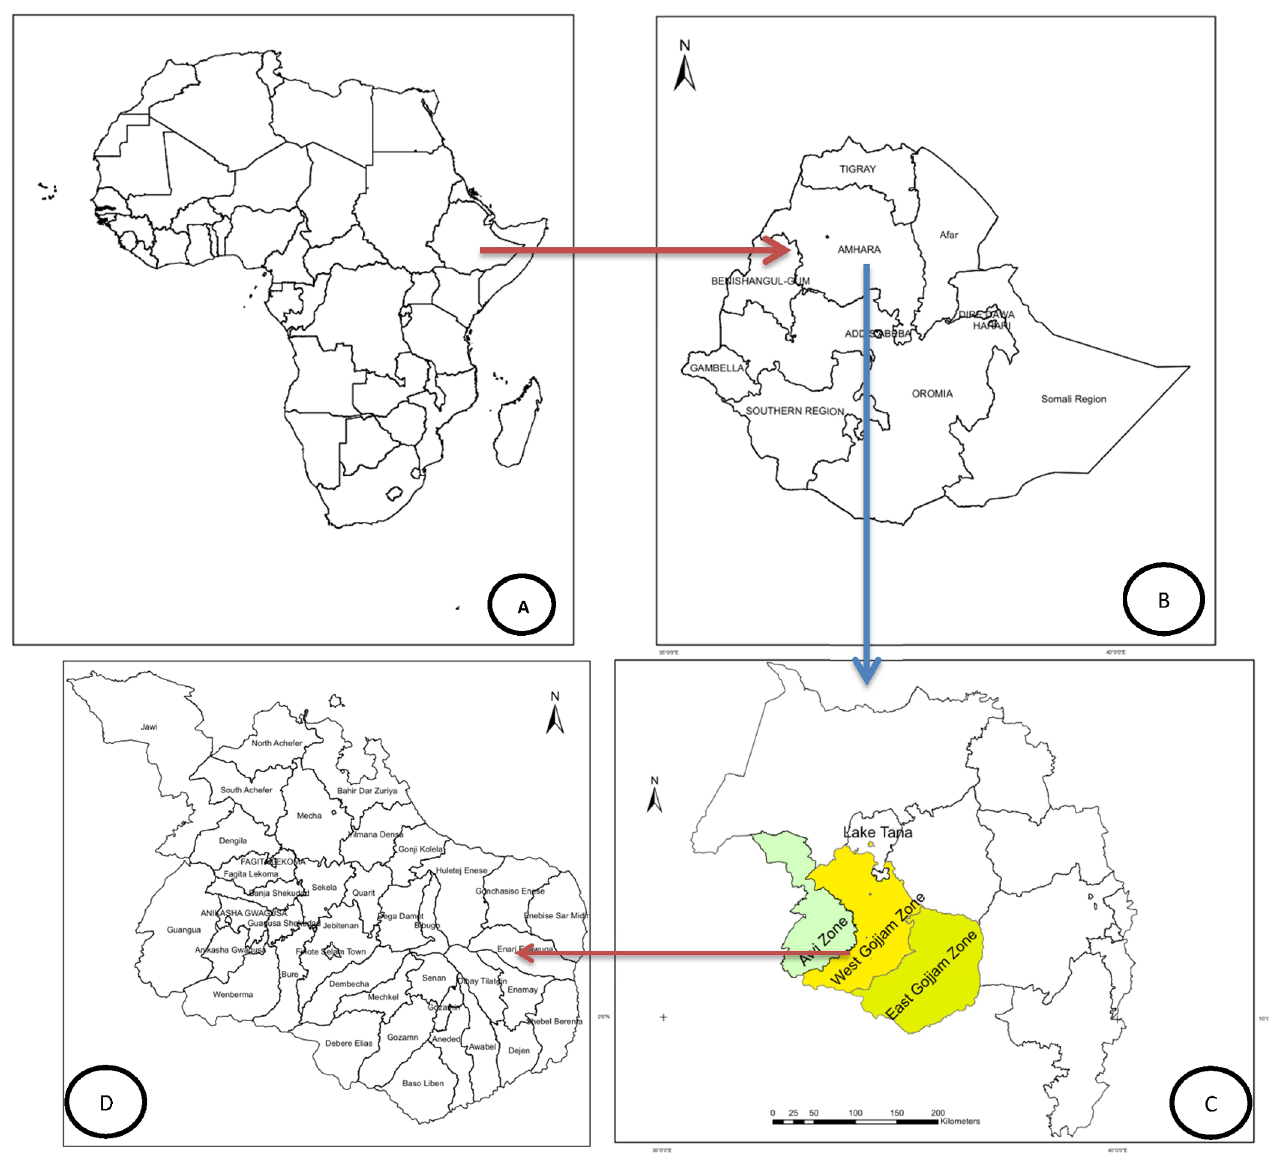
Fig 1. Map of Africa (A), Ethiopia (B), Amhara Region (C) and districts in the study area